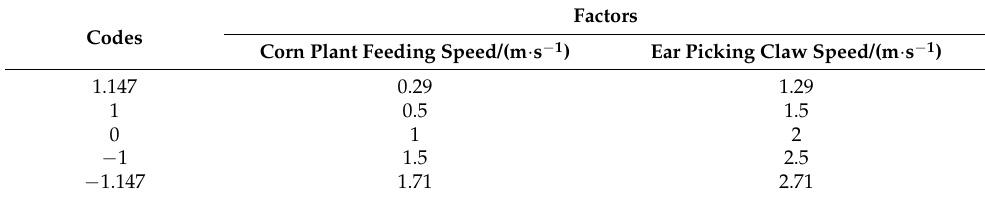
Table 2. Codes of the experimental factors.